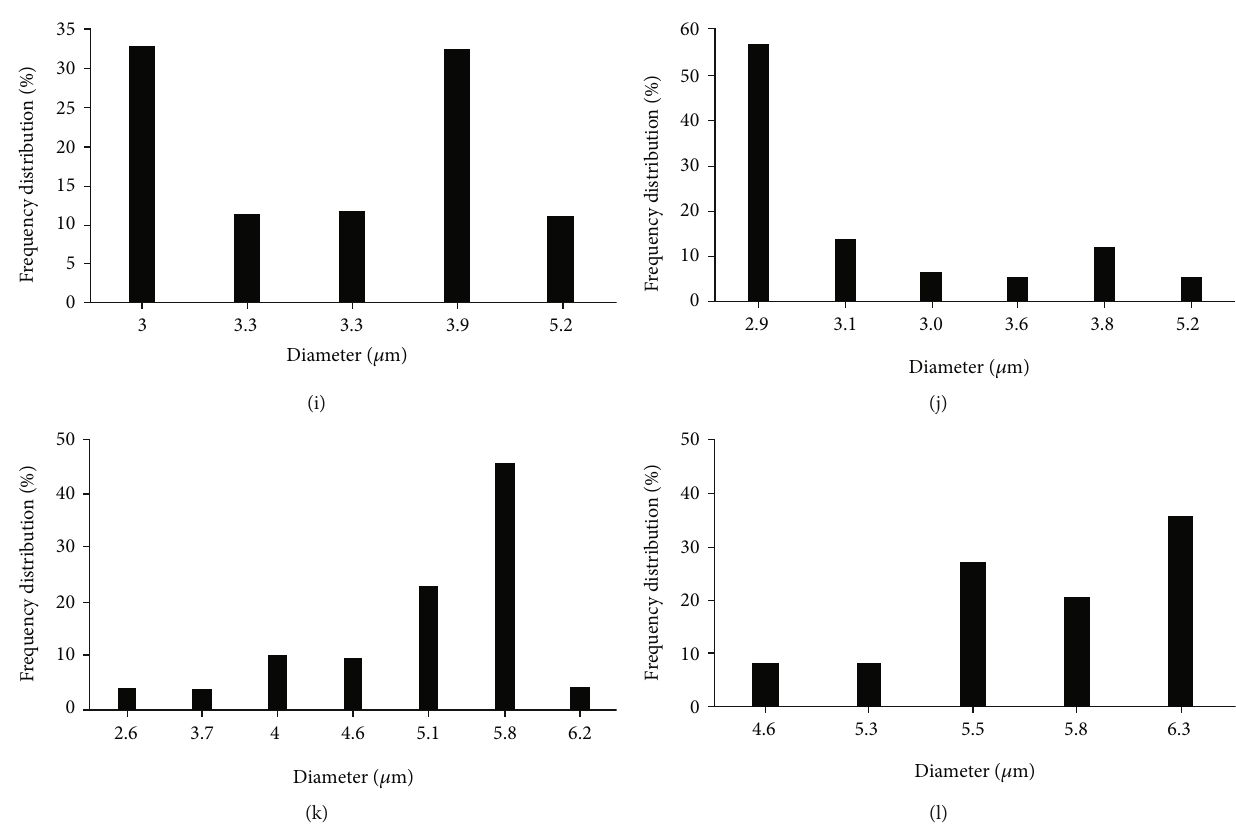
Figure 1: Scanning electron micrographs and frequency distribution of the fi ber diameters of the electrospun POM/ β -CD micro fi bers with di ff erent contents of β -CDs (a, g) 0 wt.% β -CDs, (b, h) 10wt.% β -CDs, (c, i) 20 wt.% β -CDs, (d, j) 30wt.% β -CDs, (e, k) 40 wt.% β -CDs, and (f, l) 50wt.% β